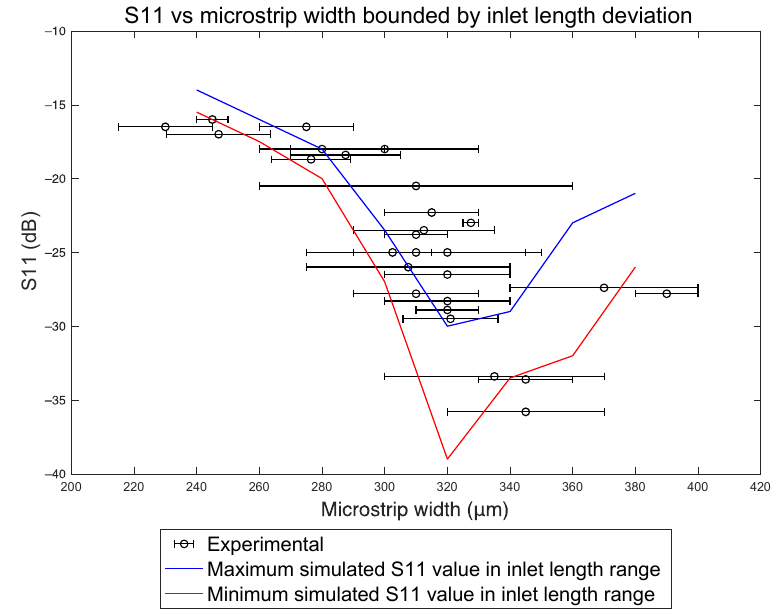
Figure 5. Simulated performance across the average +/ − standard deviation of inlet length at each microstrip width forming ranges of RF performance. The bounds follow a similar trend as the inlet width dictated bounds (Figure 4), but do not form a fully predictive model.